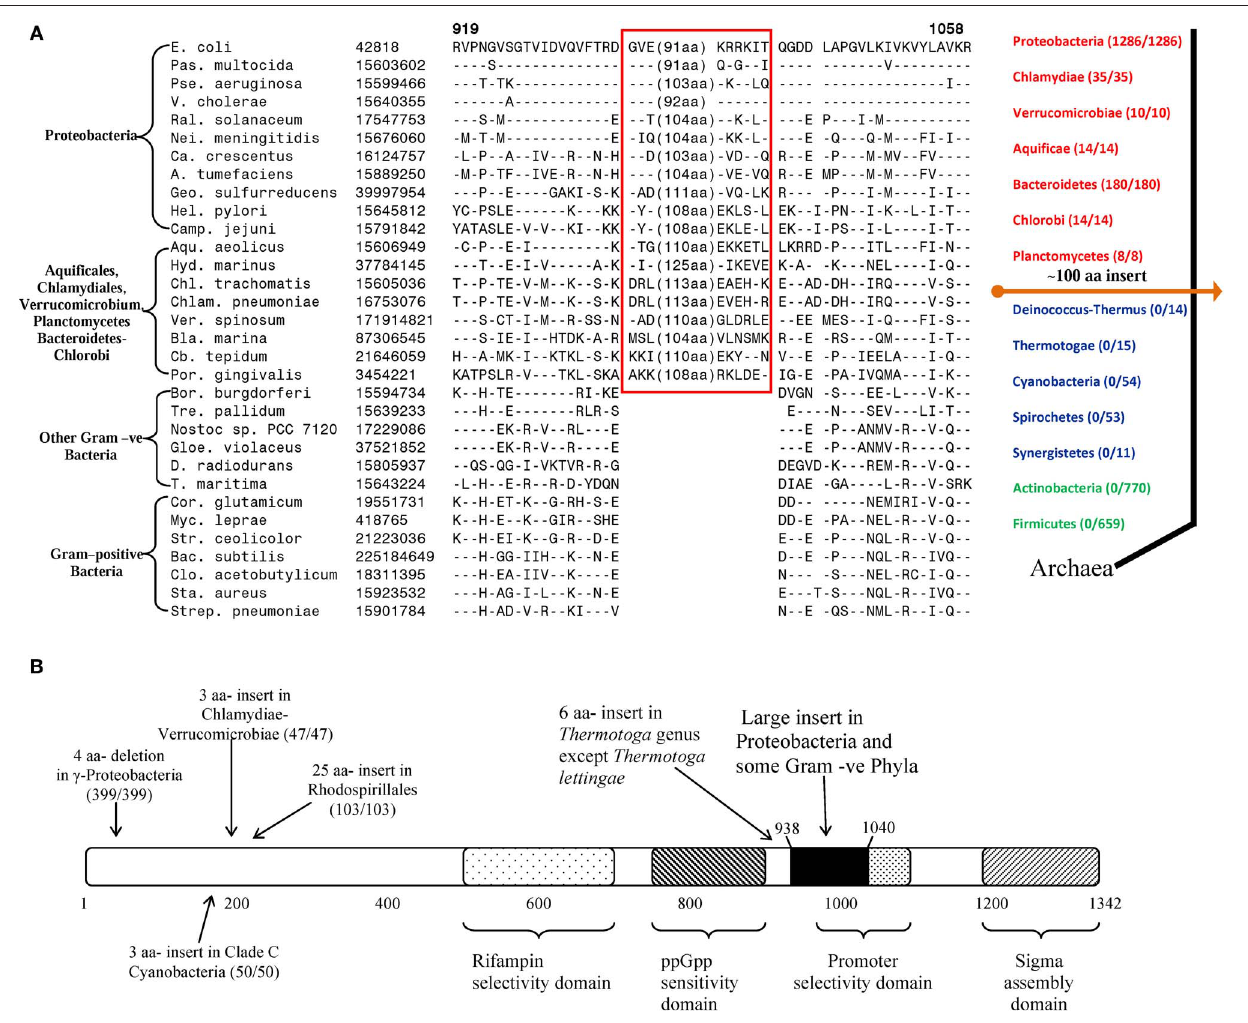
FIGURE 3 | Evolutionary significance of various identified CSIs in the RNA polymerase β subunit. (A) A portion of the RpoB sequence alignment showing a large insert (boxed) that is distinctive characteristic of all Proteobacteria and some Gram-negative phyla (Chlamydiae-Verrucomicrobiae, Aquificales, Planctomycetes, and Bacteroidetes-Chlorobi), but not found in other phyla of bacteria. Due to the large size of the insert, its entire sequence is not shown. Dashes (–) indicate identity with the amino acid on the top line. On the right is a linear representation of prokaryotic relationships based on the presence and absence of this CSI. The numbers in the brackets indicate the species of each phylum, which have been identified to contain the CSI. (B) A schematic